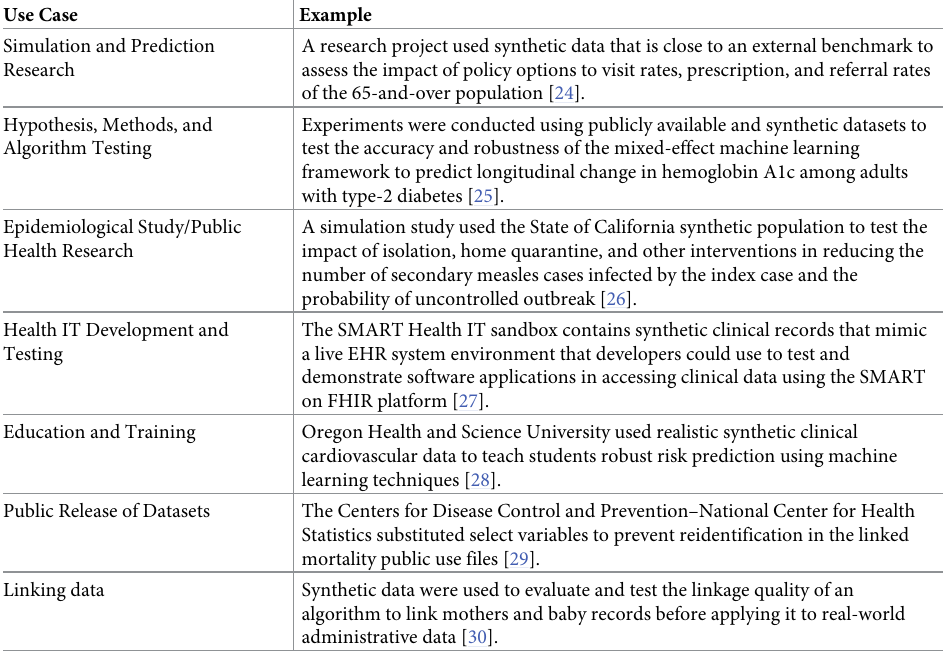
Table 1. Summary of identified synthetic data use cases in health care and